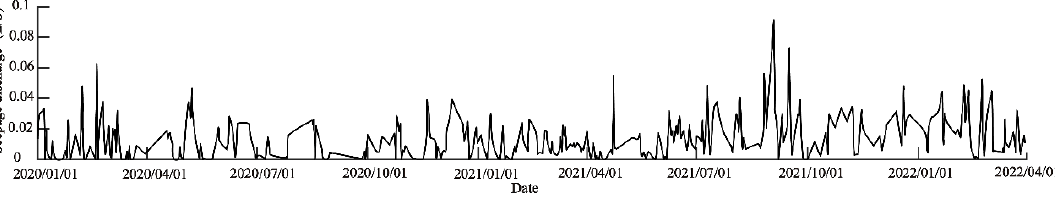
Figure 9. Process line of foreign water of seepage discharge at measuring point WE01XFG.